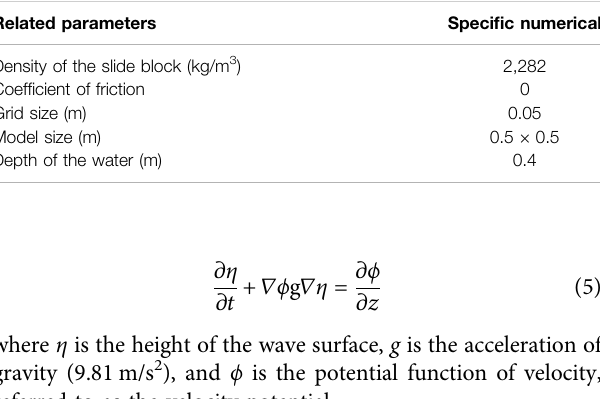
TABLE 1 | Landslide model input data.